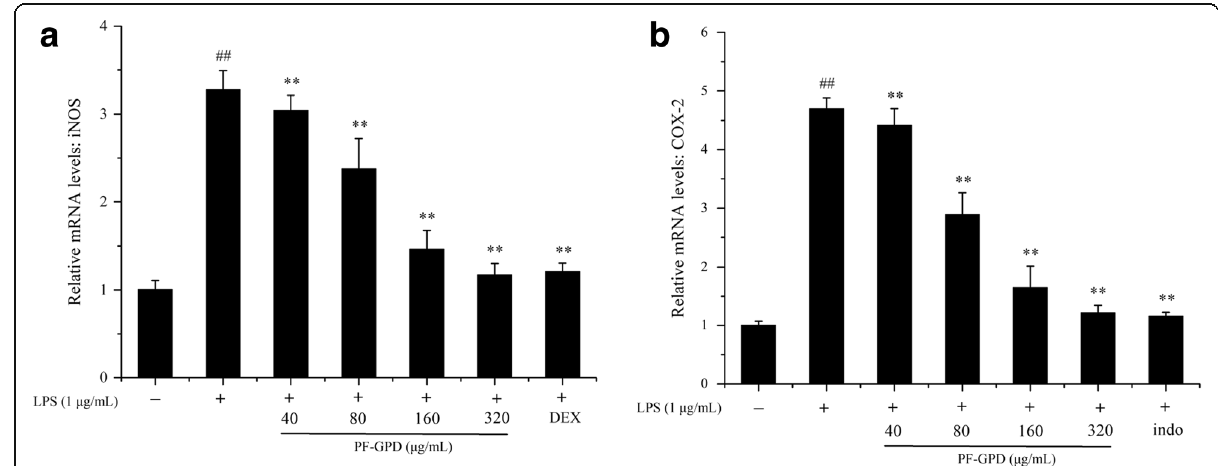
Fig. 6 Effect of PF-GPD on activation of NF- κ B in RAW 264.7 cells. Cells pretreated with indicated concentrations of PF-GPD for 6 h were stimulated without or with 1 μ g/mL of LPS for 1 h. The phosphorylation of I κ B- α ( a ) and nuclear translocation of NF- κ B were determined by Western Blot ( b and c ). The results are representative of 3 independent experiments. ## P < 0.01 compared with untreated group; * P < 0.05, ** P < 0.01 compared with the LPS